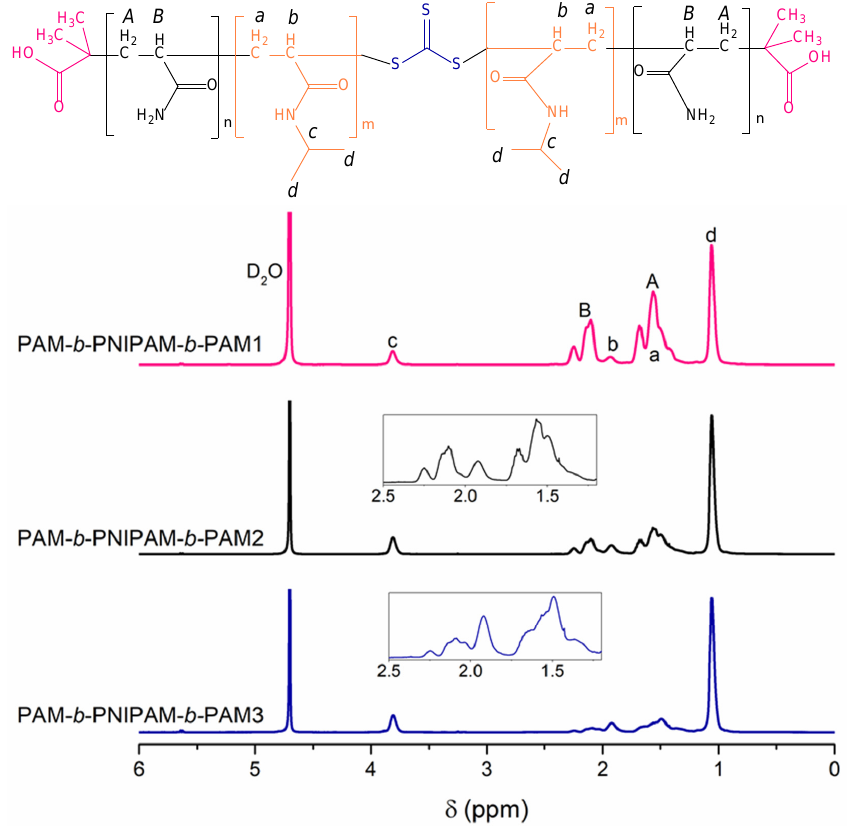
Figure 3. 1 H NMR spectra of triblock copolymers prepared by varying the macro-RAFT agent and NIPAM monomer feed. The chemical shifts of the PAM and PNIPAM blocks are represented by uppercase and lowercase letters, respectively. The PAM- b -PNIPAM- b -PAM2 and PAM- b -PNIPAM- b -PAM3 spectra show a magni fi cation at 2.5–1.2 ppm to observe the variation of the intensity of the signals.